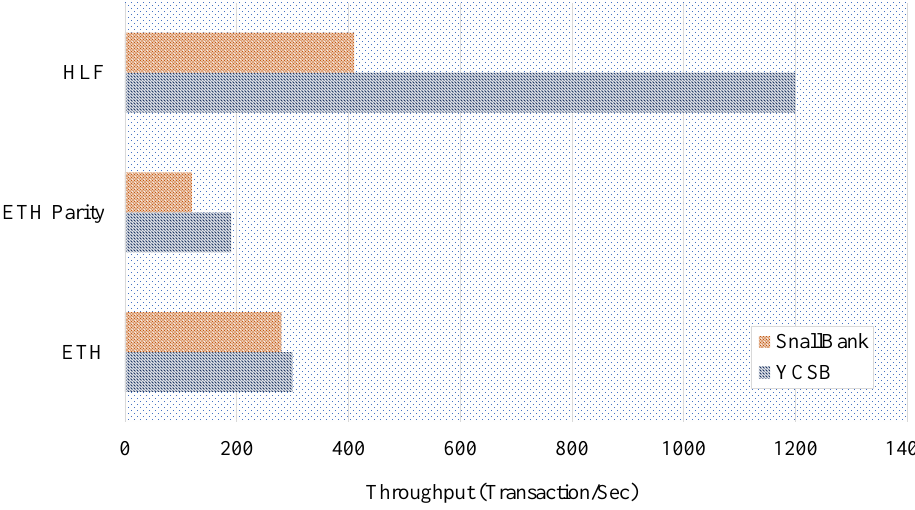
Figure 8. Throughput comparison between ETH, ETH Parity, and HLF Fabric.